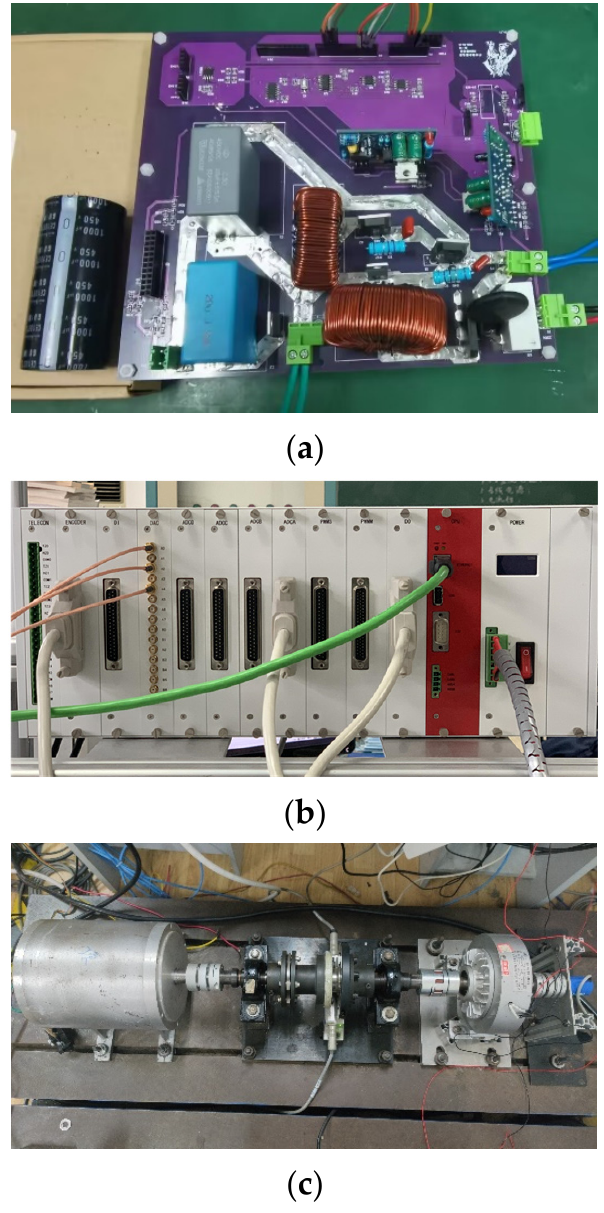
Figure 6. The experimental platform of ECL drive system. ( a ) Power converter. ( b ) The hardware-in-the-loop simulation platform Rtunit. ( c ) Motor test platform. Table 1. Key parameters of the ECL motor drive.